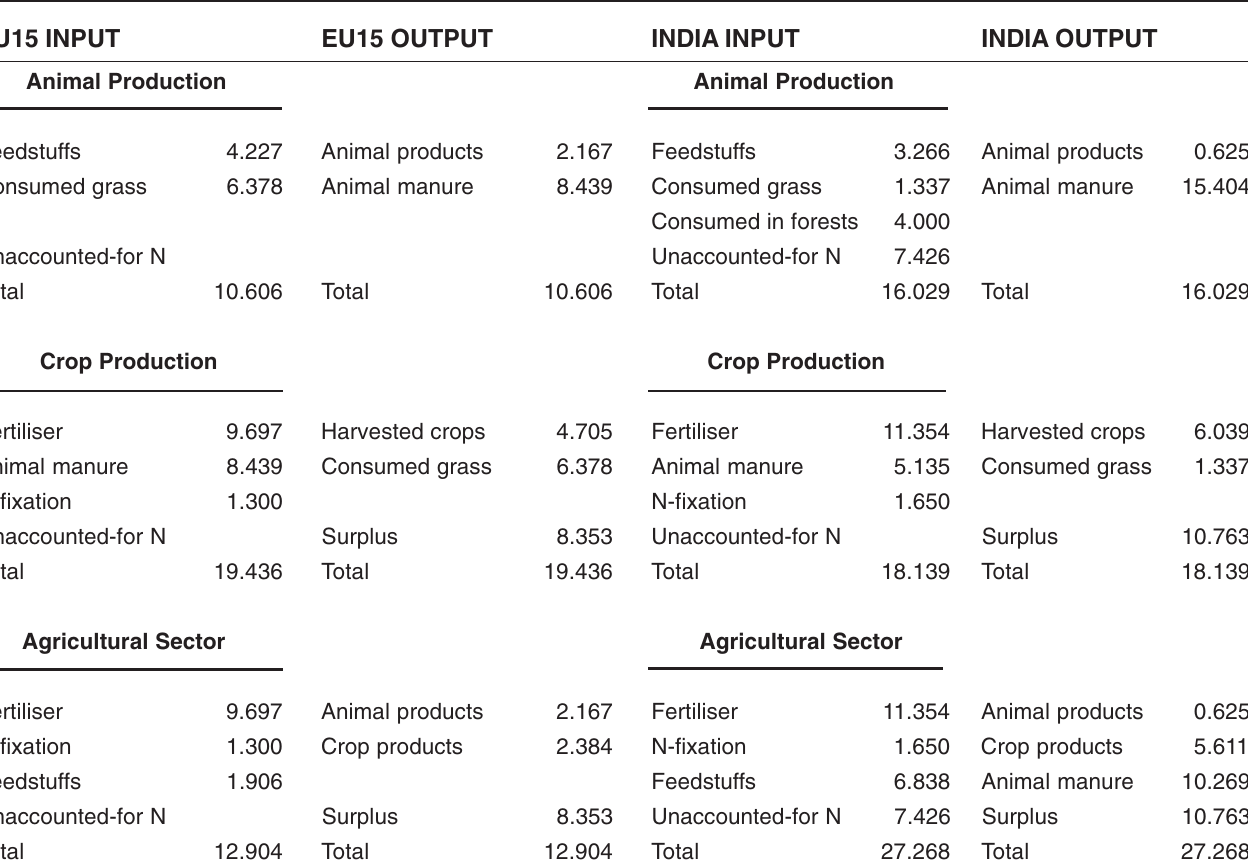
Nitrogen Balance Sheets for Animal